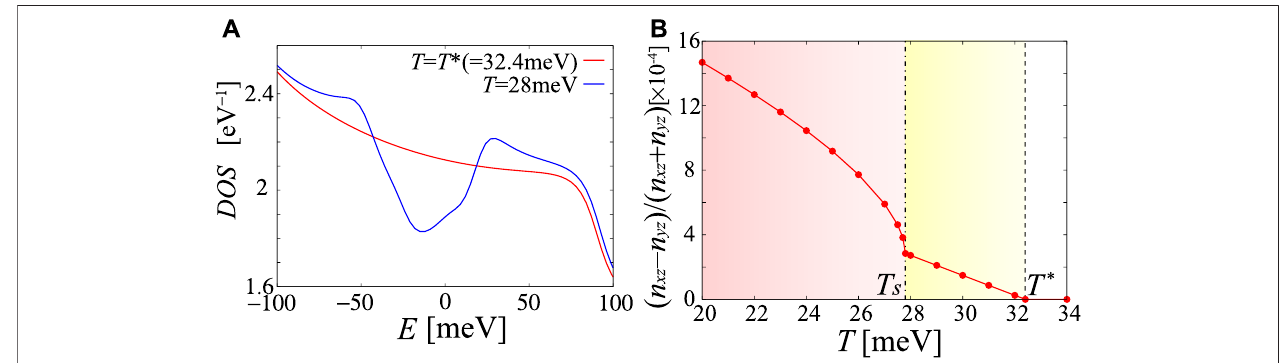
FIGURE 11 | (A) DOS at T = T * = 32.4 meV and that at T = 28 meV( < T *), including the smectic bond order. (B) T dependence of nematicity ψ = ( n 2 − n 3 )/( n 2 + n 3 ) including both the smectic-bond order for T < T * and the ferro-orbital/bond order for T < T S .